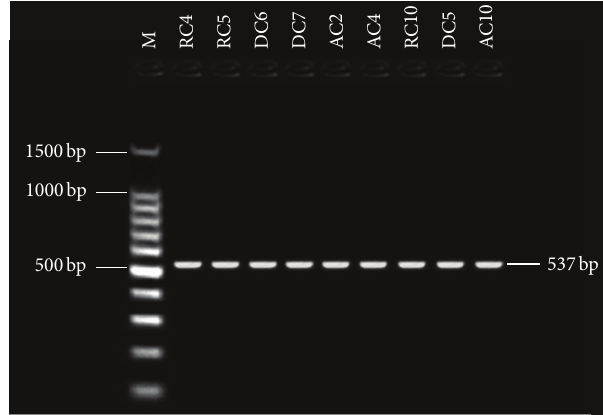
Figure 3: Gel electrophoresis analysis PCR products using aflR primer with 1032 bp, lanes from RC4 to AC4 ( A. flavus ), lanes from RC10 to AC10 ( A. parasiticus ), and lane M: 100bp DNA ladder size marker.